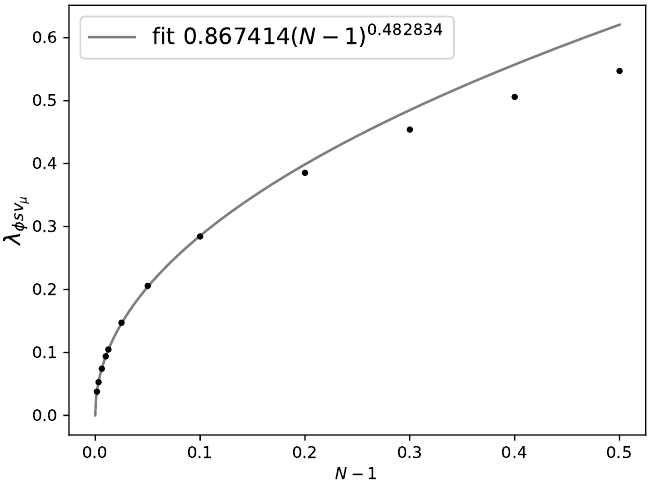
Figure 10: Plot of the φ × s OPE coefficient of the lowest-lying spin-1 V primary, along with a fit of all values excluding those over N = 1.1.